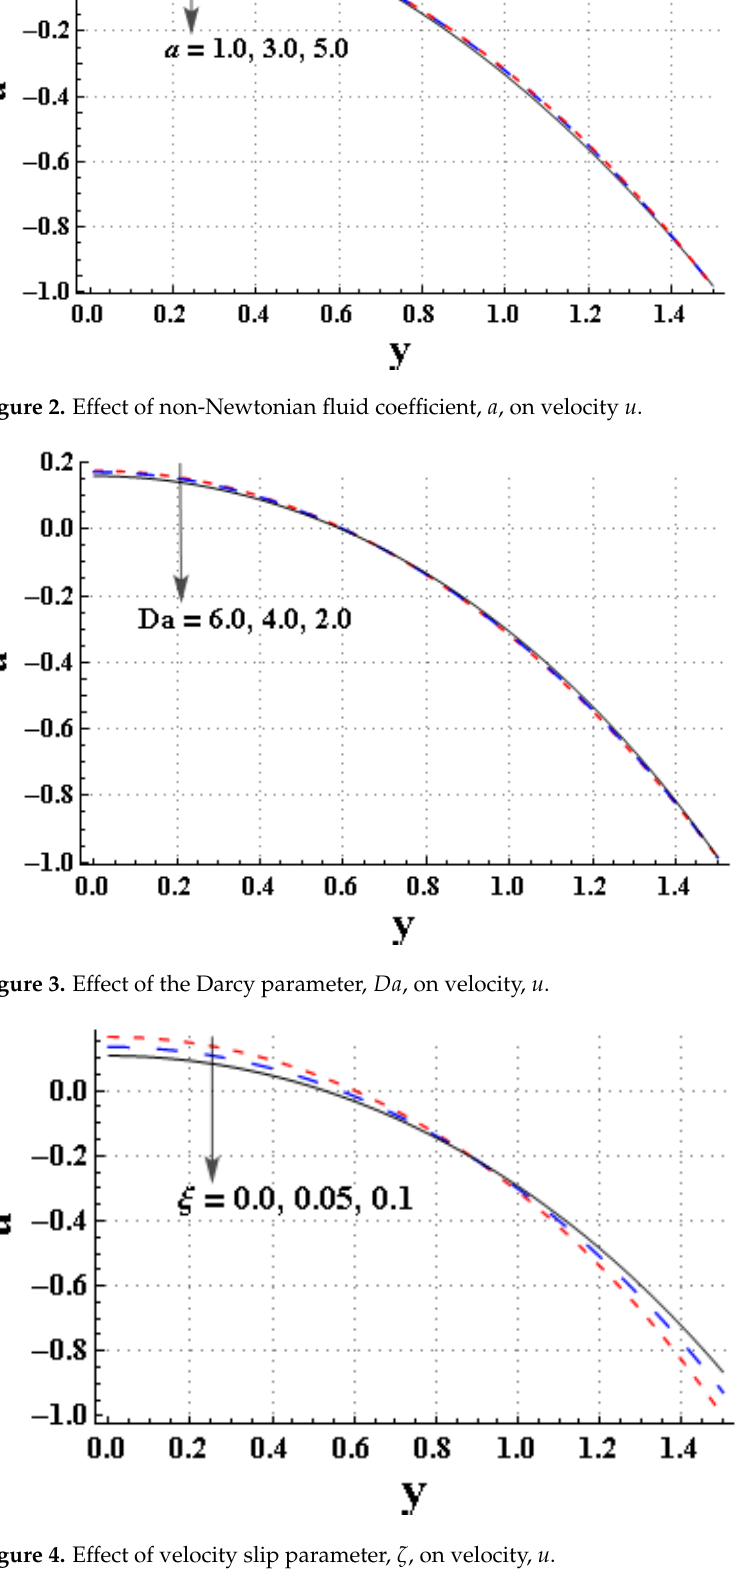
Figure 4. Effect of velocity slip parameter, ζ , on velocity, u